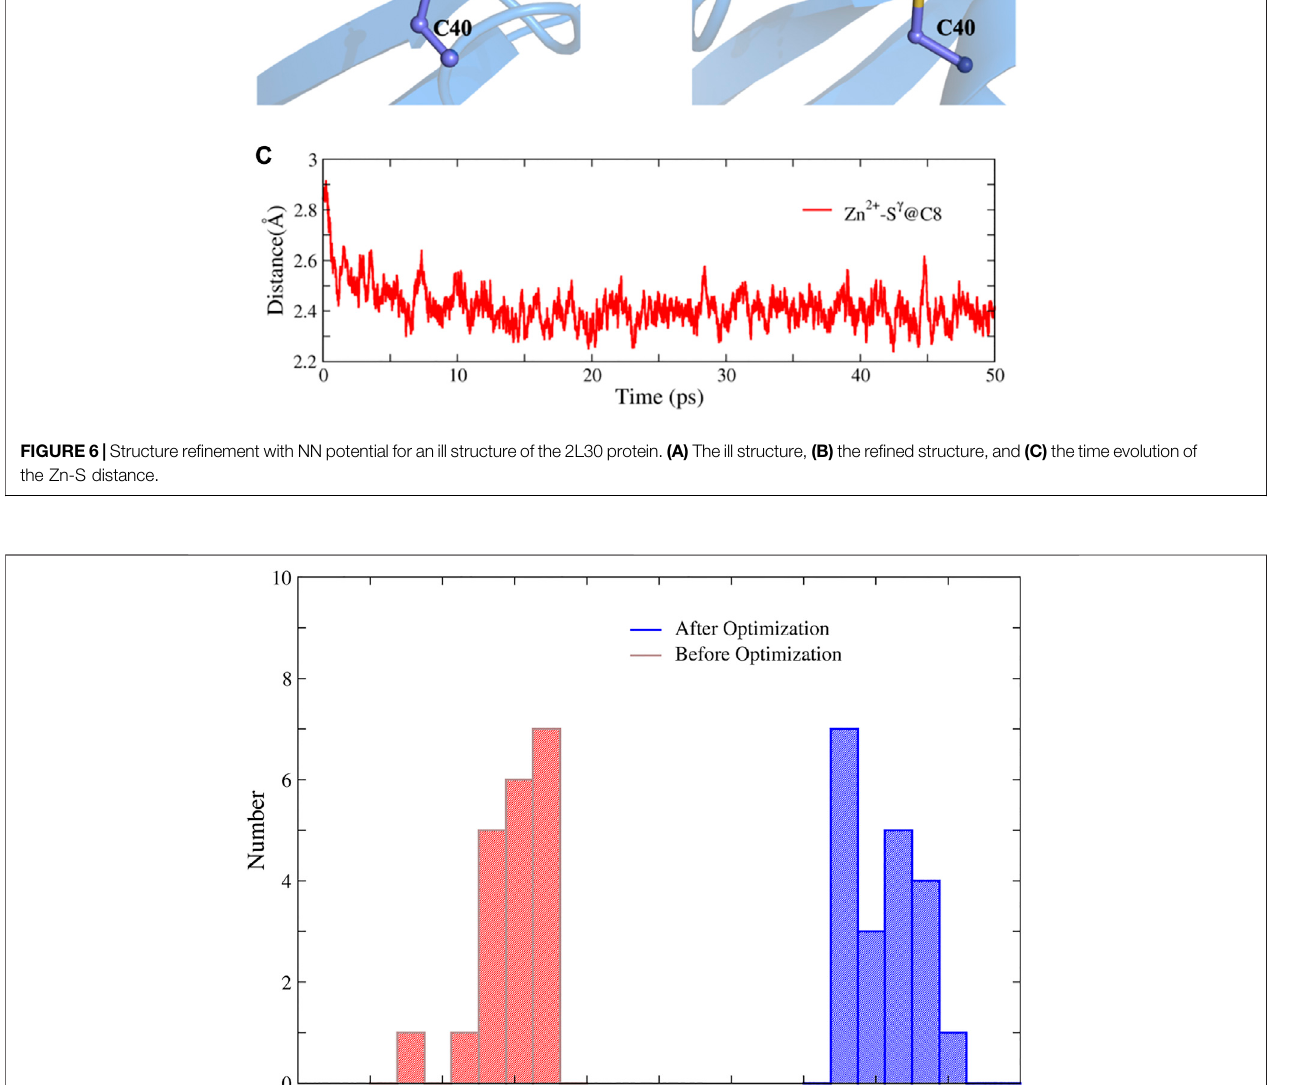
Frontiers in Chemistry |